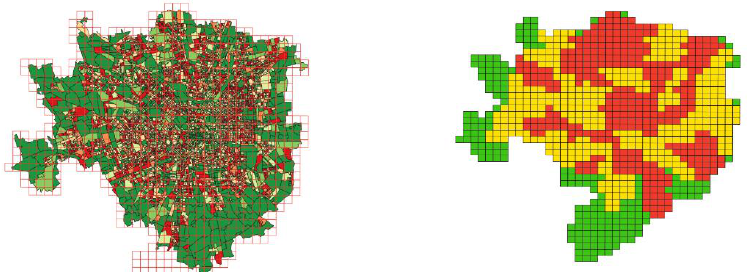
Figure 12. Left picture: classification of census tracts based on the population density (from green, low density, to red, high density); right picture: representation of the squares based on the area classification: green for low-density, yellow for medium-density, red for high-density.